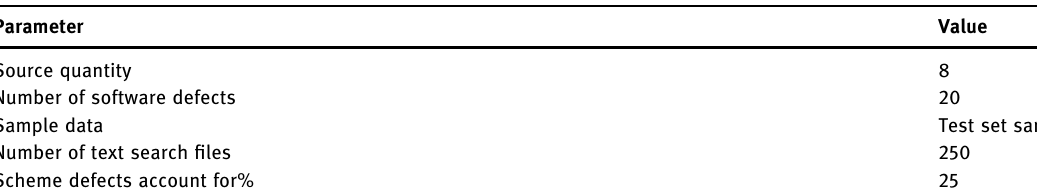
Table 1: Experimental parameters